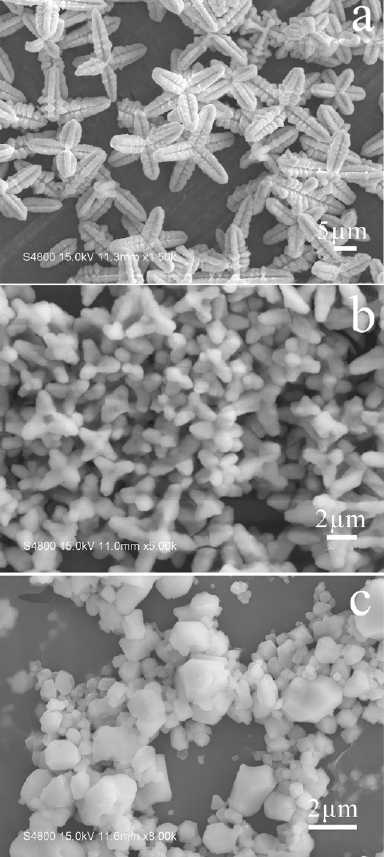
Figure 4. The SEM images of the Cs 2 SnCl 6 crystals prepared at 5 mol/L HCl concentration for different SnCl 2 concentrations: ( a ) 0.042 mol/L, ( b ) 0.083 mol/L, ( c ) 0.167 mol/L.